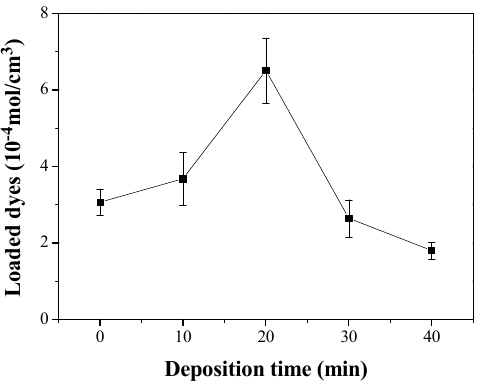
Figure 6 Figure 6. Amounts of N719 dyes as a function of deposition time of silver ions; where N719 dyes adsorbed on the ZnO nonorod surface were detached using an aqueous NaOH solution, and used in absorbance measurements.